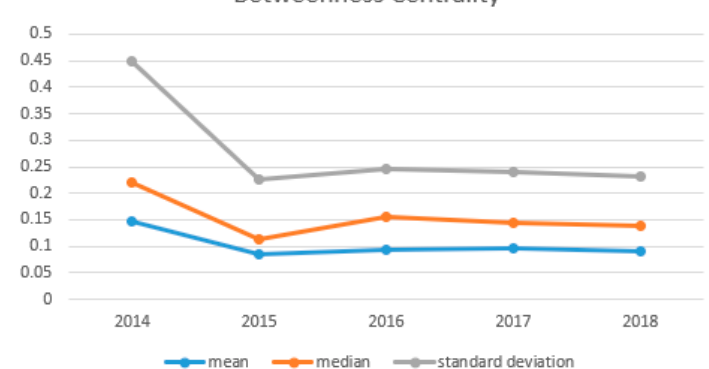
Figure 9. The statistical indicators of betweenness centrality curve during 2014–2018.